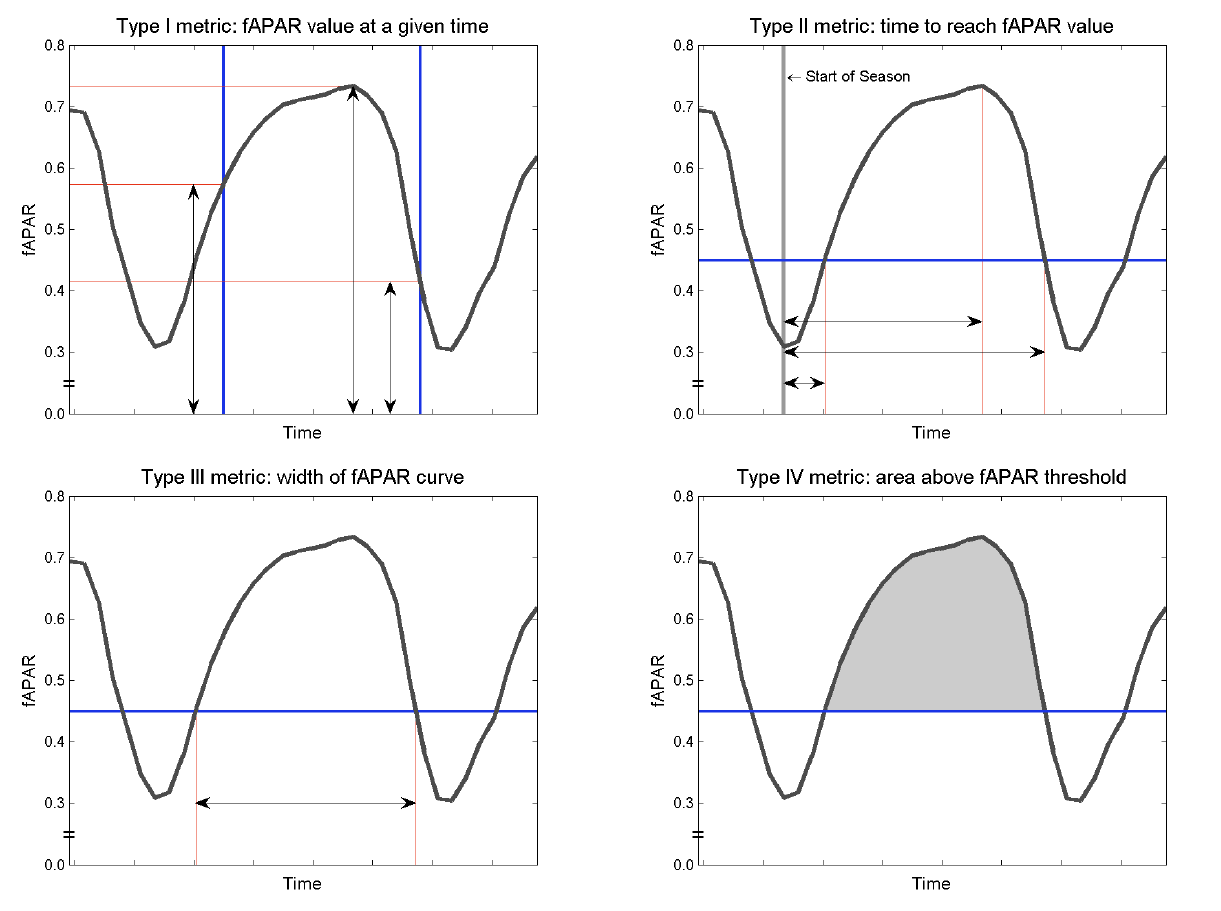
Figure 4. Illustration of the different types of metrics derived from the smoothed fAPAR time series for every growing season. The blue lines represent the threshold in the metric defining variable while the arrows or the shaded region represent the values of the